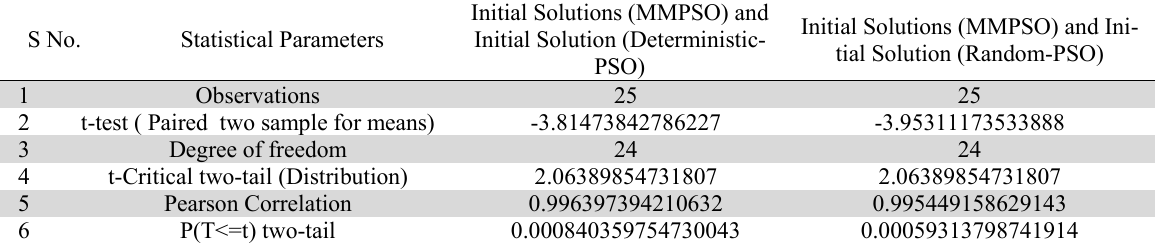
Student’s t-Test Result (Paired two sample for means) between Initial Feasible Solution alternatives PSO and MMPSO (Deterministic;